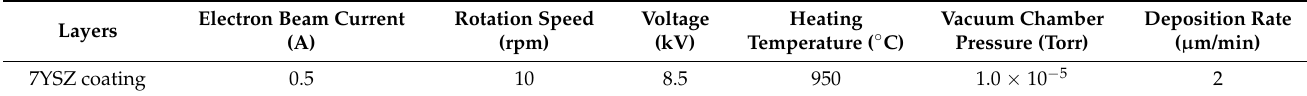
Table 3. EB-PVD parameters for the 7YSZ